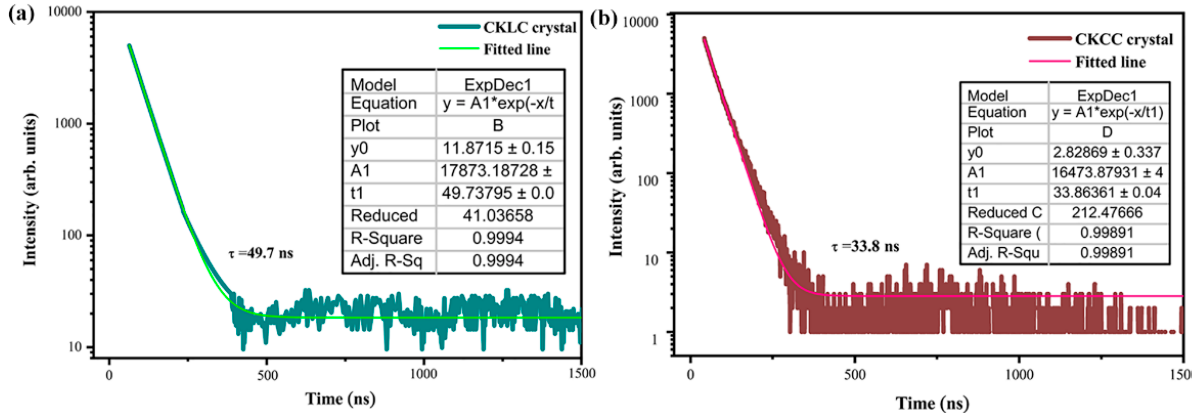
Figure 5. Photoluminescence decay time profiles of ( a ) CKLC and ( b ) CKCC crystals.